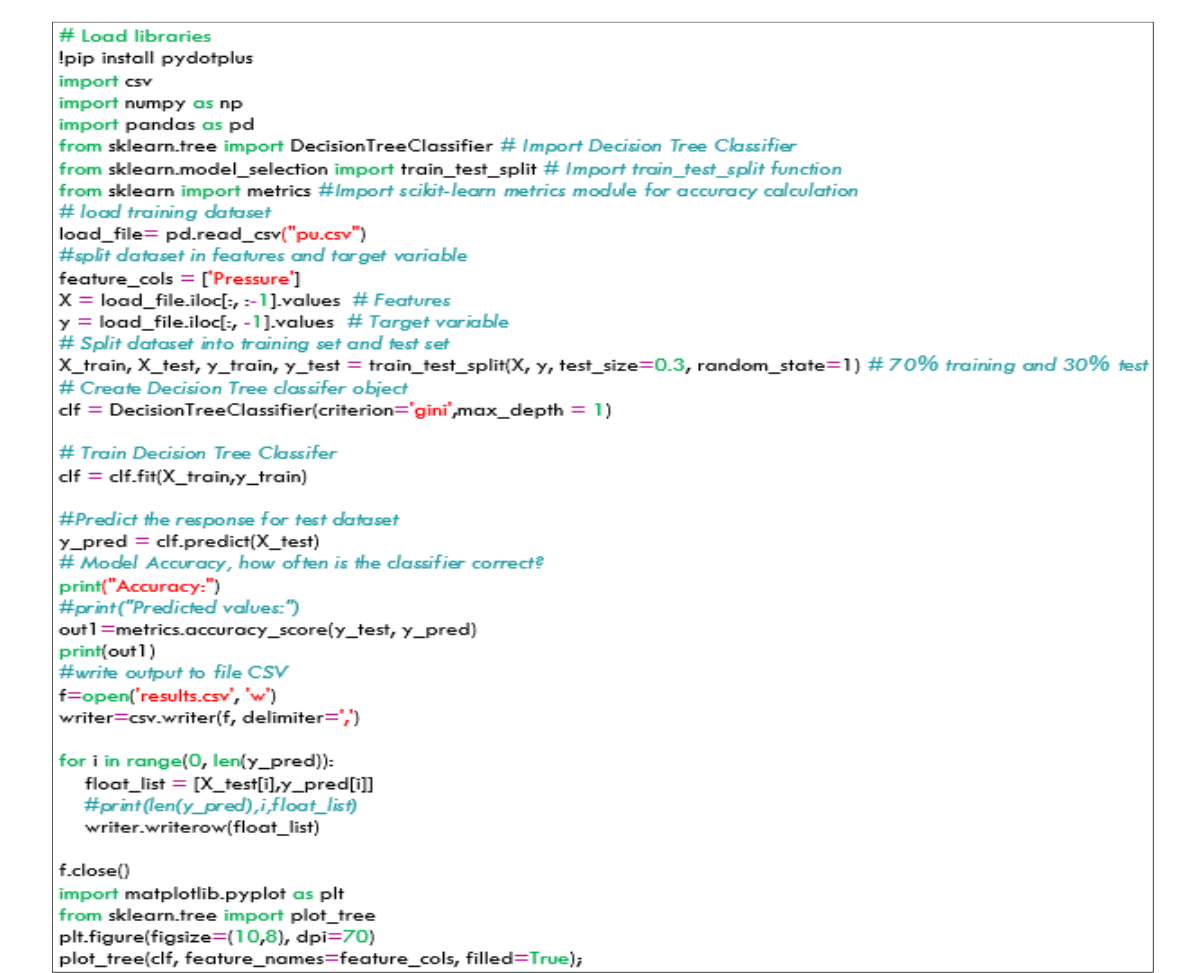
Figure 8. DT Python Code.